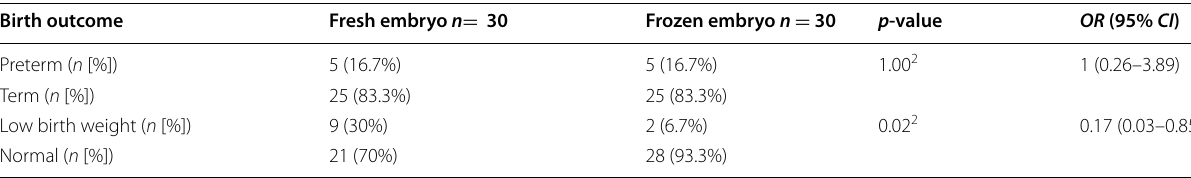
Table 2 Perinatal outcome